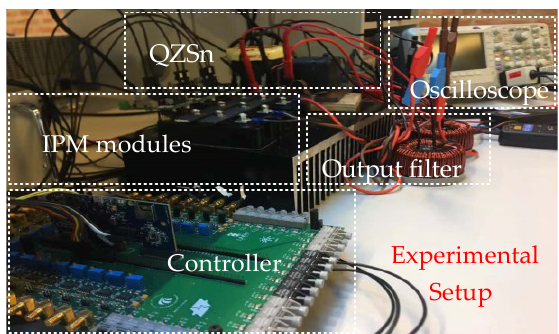
Figure 9. Photograph of the experimental setup of the three-phase qZSI system.